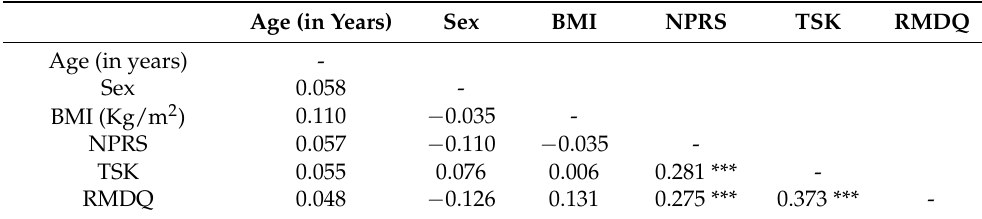
Table 2. Pearson and point-biserial correlations coefficients between age, sex and BMI with the measures of pain intensity, kinesiophobia and disability.